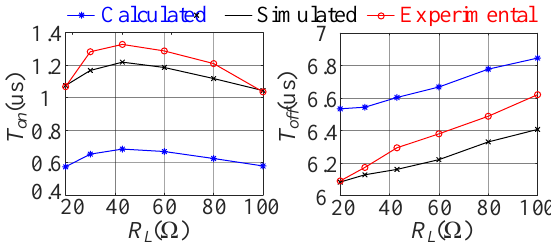
Figure 9. Comparison of calculated, simulated, and experimental critical ZVS conditions under different load resistances.